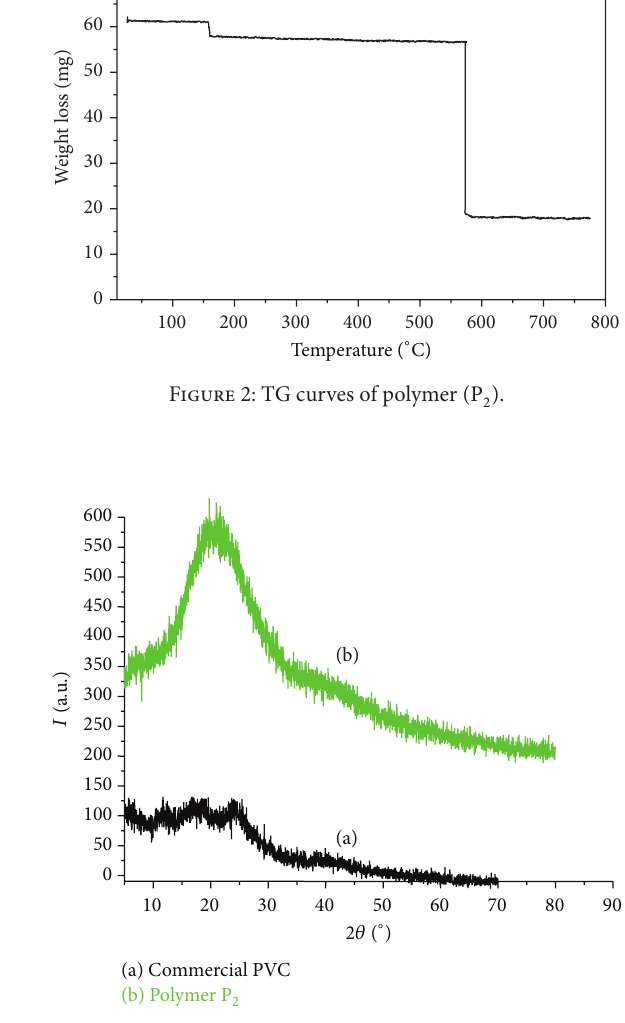
Figure 3: XRD of commercial PVC and polymer (P 2